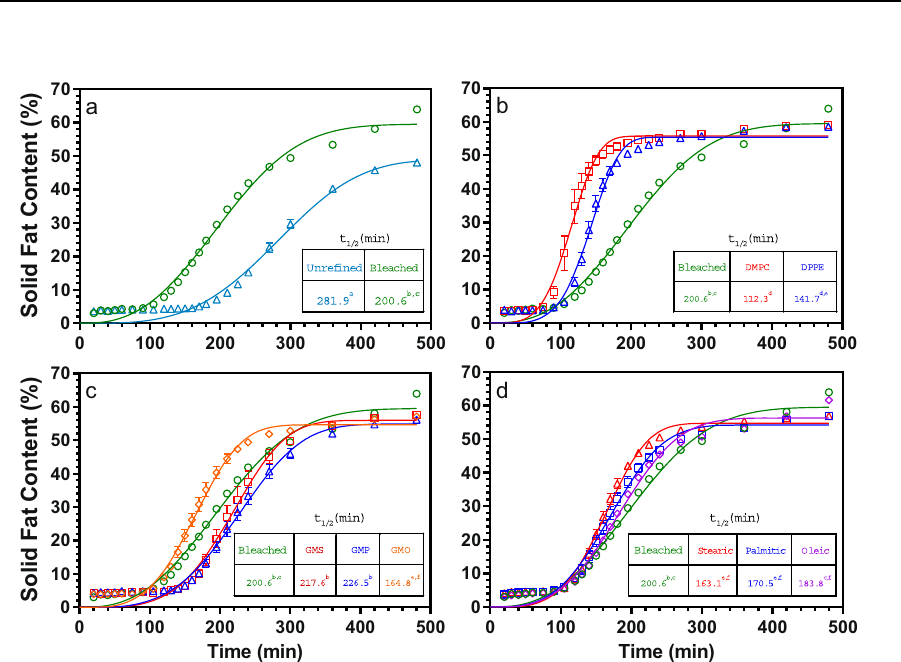
Fig. 2 Static crystallization growth curve of unre fi ned native CB, re fi ned CB, and re fi ned CB with added minor lipidic components crystallized at 23 °C (symbols) and corresponding fi ts to the Avrami model (solid lines). The inset table indicates the half-times of crystallization derived form model fi ts. Re fi ning CB accelerates its crystallization ( a ), as does 0.1% (w/w) phospholipid addition ( b ). Addition of 0.5% (w/w) saturated monoacylglycerols, glycerol monostearate, and glycerol monopalmitate, do not signi fi cantly affect crystallization kinetics, while addition of the unsaturated glycerol monooletate does ( c ). Free fatty-acid addition to re fi ned CB at 0.5% (w/w) levels accelerates crystallization for stearic, palmitic, and oleic acids equally ( d ). Values represent means and standard errors of three replicates and values with the same superscript letter are not signi fi cantly different ( P >